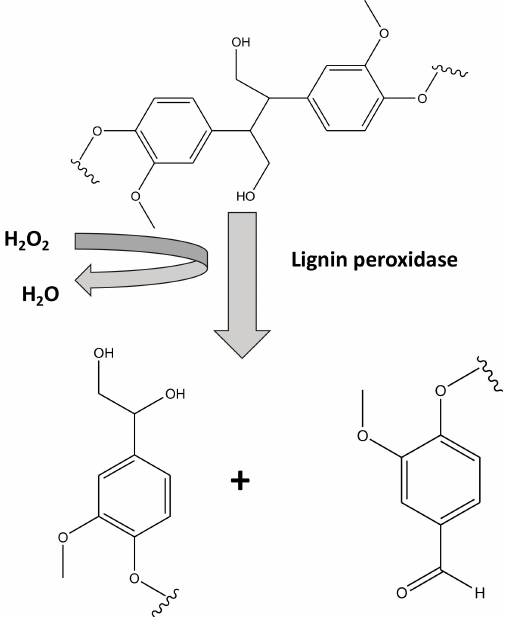
Figure 5. Simplified mechanism of action for lignin